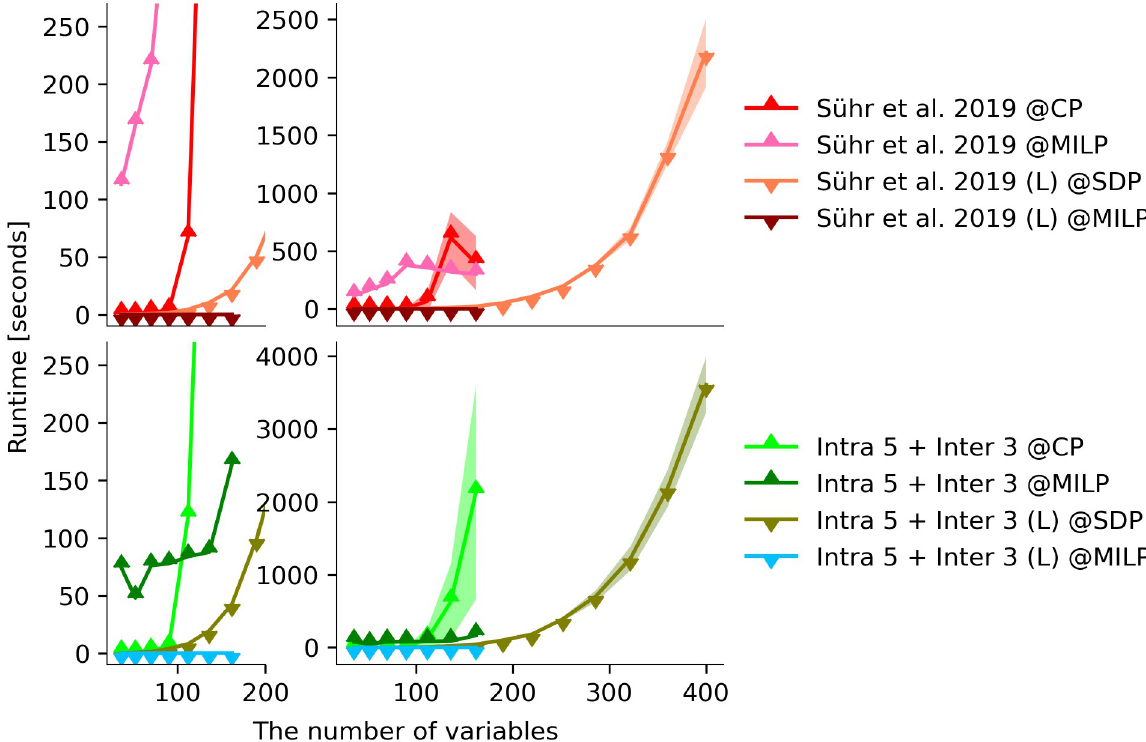
Fig 4. The runtime of formulations “Su¨hr et al. 2019” and our method Intra 5 + Inter 3 using CP Optimizer (CP), CPLEX (MILP), and an SDP solver (SDPA), with or without augmented Lagrangian relaxation, respectively. The four types of red curves denote the runtime of formulation “Su¨hr et al. 2019” (with 4 markers) and its Lagrangian variant (with 5 markers) against the number of variables. The four types of green curves denote that of formulations Intra 5 + Inter 3 and its variant. Subplots on the right present the mean runtime and mean ± one standard deviations across 5 runs by curves with shaded error bands. The subplots on the left give a zoom-in effect of the right ones, without shaded error bands.